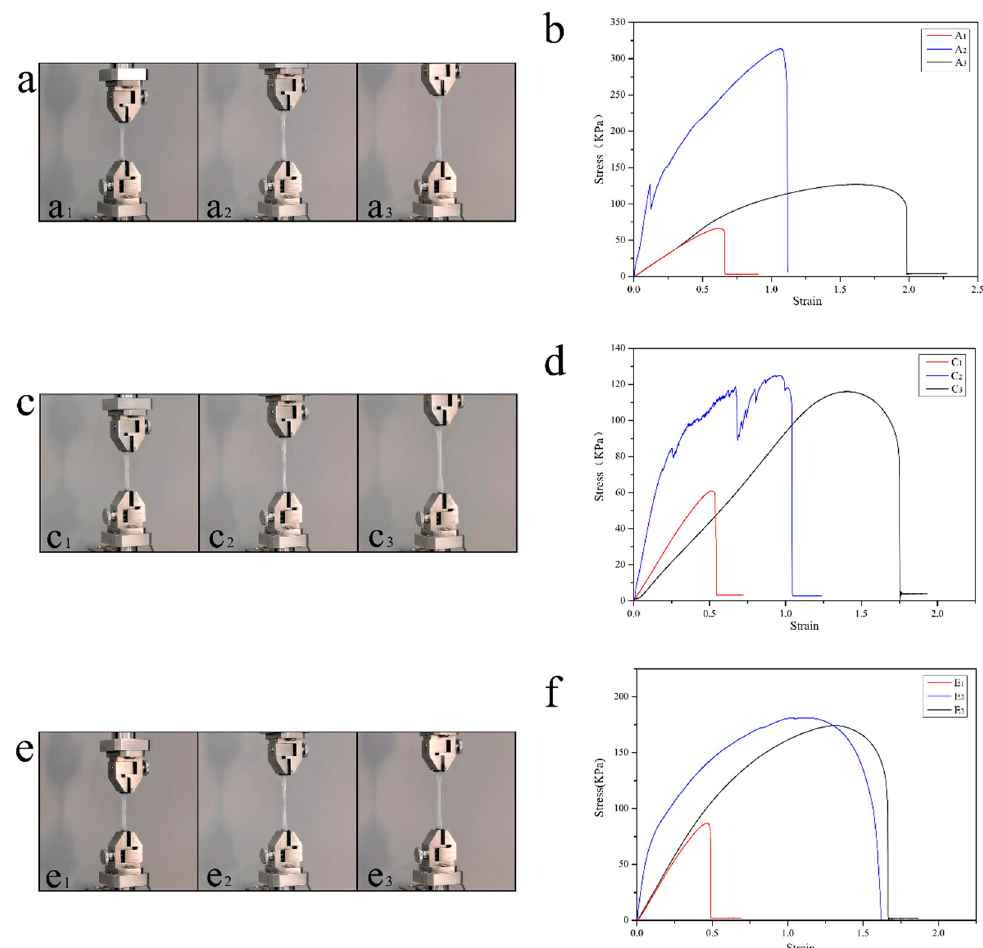
Figure 6. The artificial skin’s self-healing behavior at different temperatures. ( a ) The self-healing behavior of the artificial skin at 5 °C, ( a 1 – a 3 ) the damaged control group, the self-healing artificial skin, and the undamaged control group. ( b ) The stress–strain curves of artificial skin at 5 °C. ( c ) The self-healing behavior of the artificial skin at 25 °C and ( c 1 – c 3 ) the damaged control group, the self-healing artificial skin, and the undamaged control group. ( d ) The stress–strain curves of artificial skin at 25 °C. ( e ) The self-healing behavior of the artificial skin at 45 °C, ( e 1 – e 3 ) the damaged control group, the self-healing artificial skin, the undamaged control group. In addition ( f ), the stress–strain curves of the artificial skin at 45 °C.